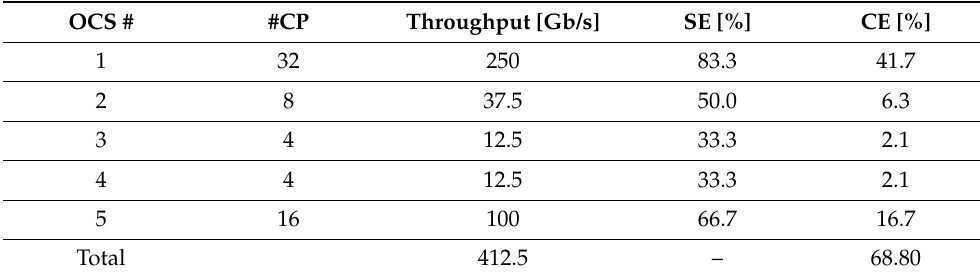
Table 1. Example of throughput, SE, and CE of each OCS i . OCS